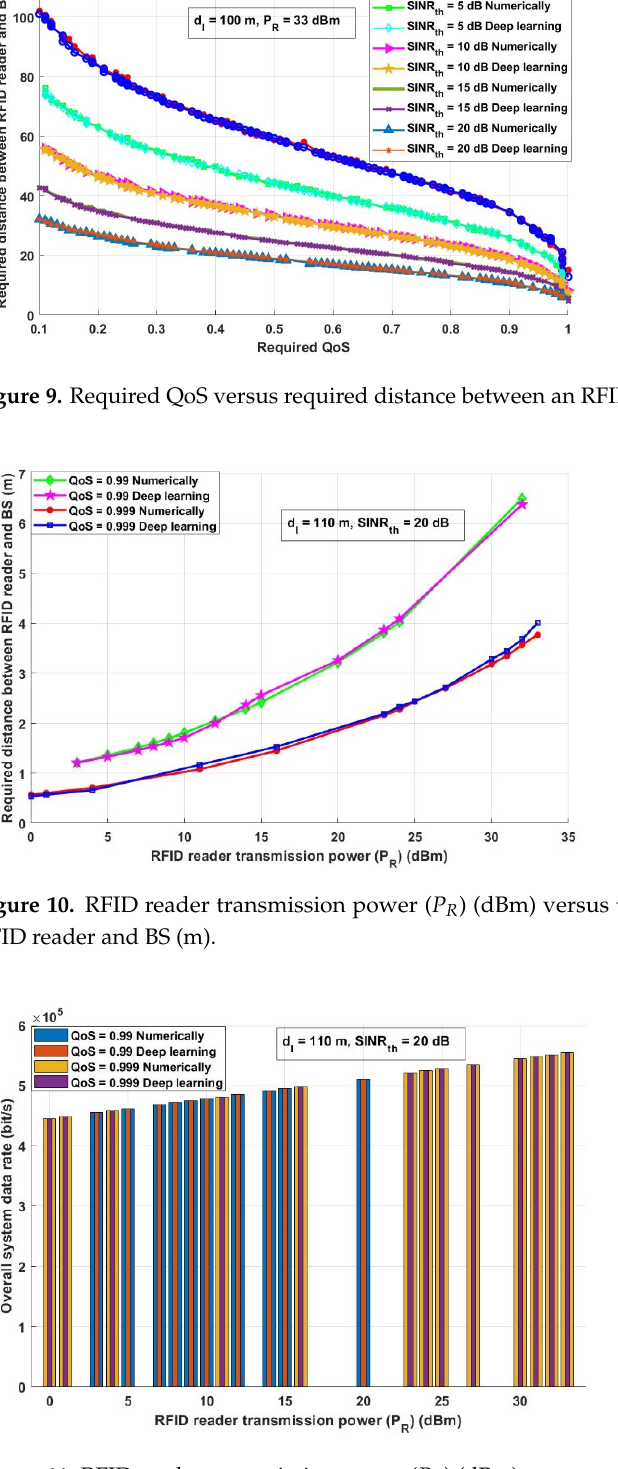
Figure 11. RFID reader transmission power ( P R ) (dBm) versus overall system data rate (bit/s).